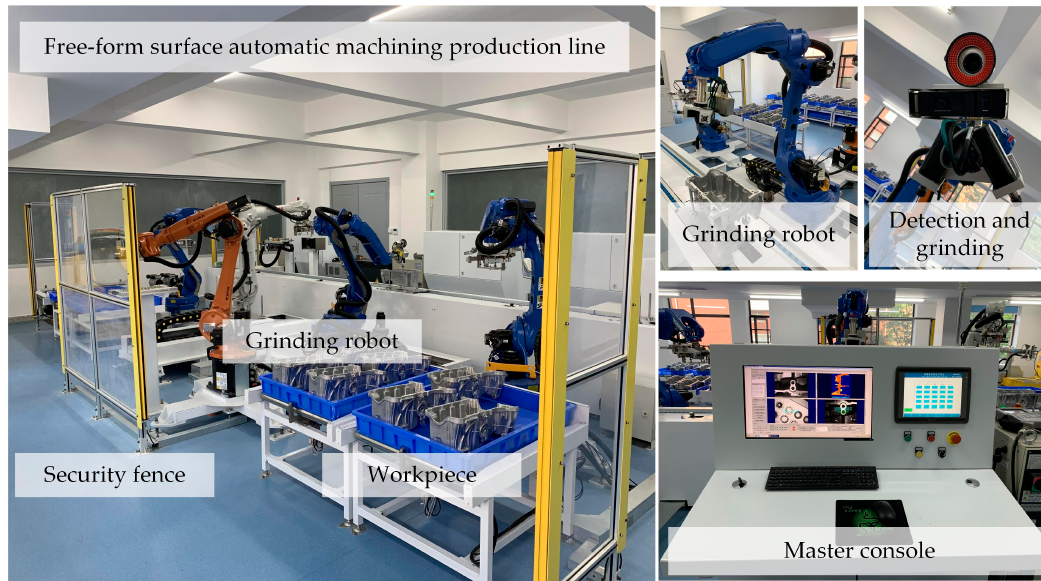
Figure 1. A free-form surface grinding robot system.